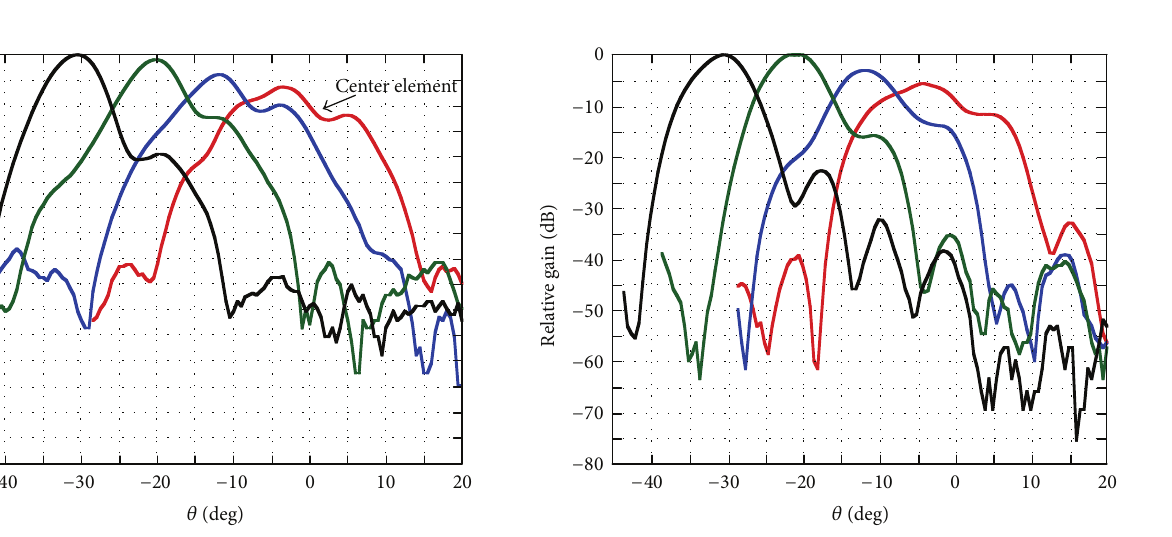
Figure 15: Far-field pattern of detector 275GHz. Figure 16: Far-field pattern of detector 300 GHz.